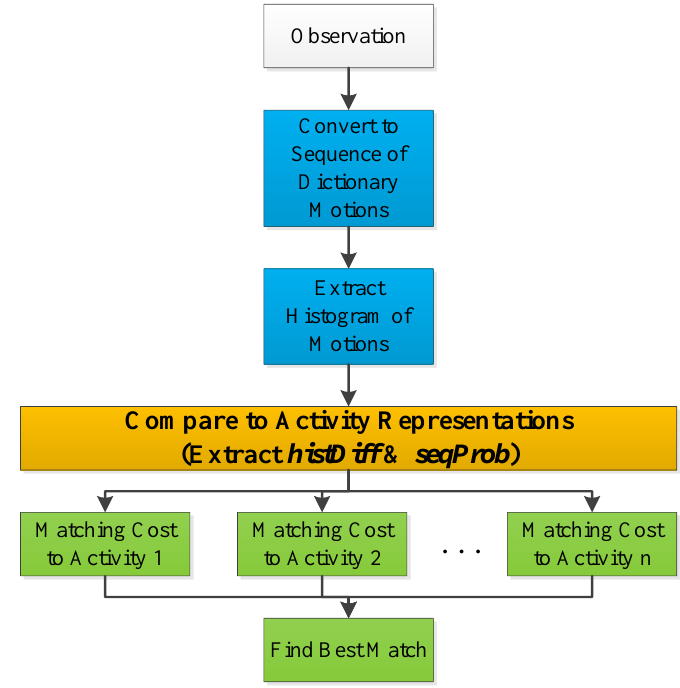
Figure 10. Flowchart of the inference phase.